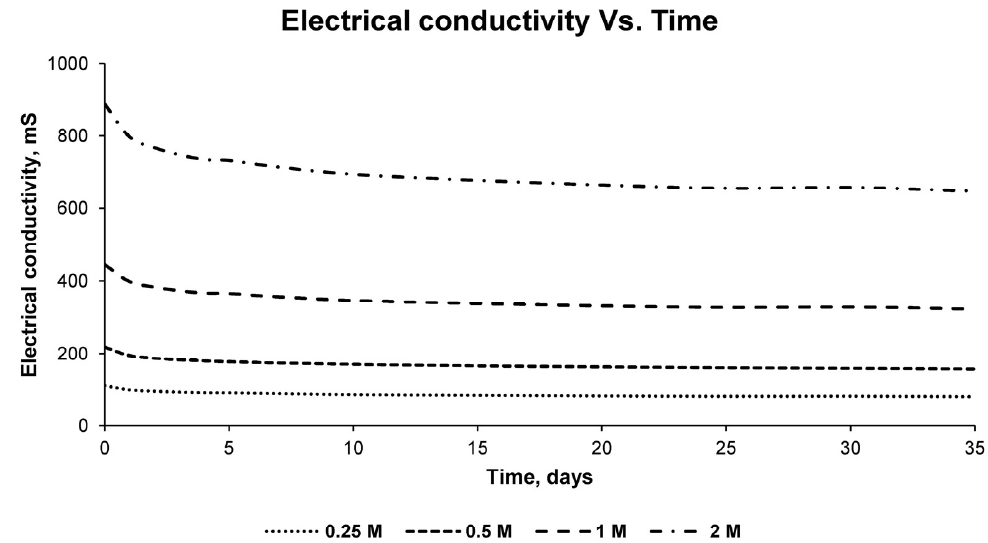
Figure 6. Graph of the electrical conductivity of the leachate, as a function of time, for the 0.25 mo- lar, 0.50 mol, 1.00 mol, and 2.00 mol sulfuric acid solutions.